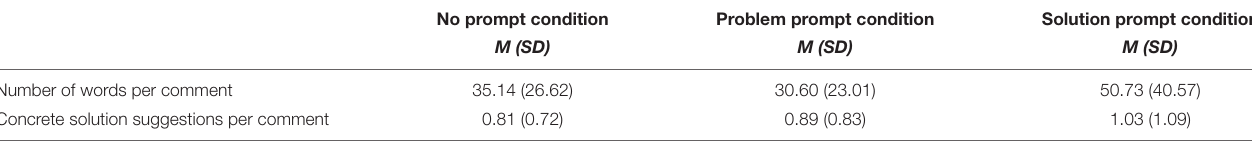
TABLE 1 | Comprehensiveness of comments and concrete advice in the three conditions in Study